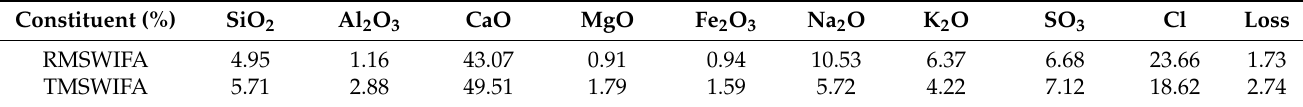
Figure 6. XRD patterns of RMSWIFA and TMSWIFA (1-CaCO 3 (PDF#72-1653), 2-CaSO 4 (PDF#37- 0184), 3-CaSO 4 ·H 2 O (PDF#39-0725), 4-CaClOH (PDF#73-1885), 5-KCl (PDF#75-0298), 6-NaCl (PDF#88-2300), 7-SiO 2 (PDF#79-1906), 8-CaAl 2 Si7O 18 ·1.7H 2 O (PDF#21-0132), 9-CaAl 2 Si 7 O 18 ·3.5H 2 O (PDF#24-0765)).